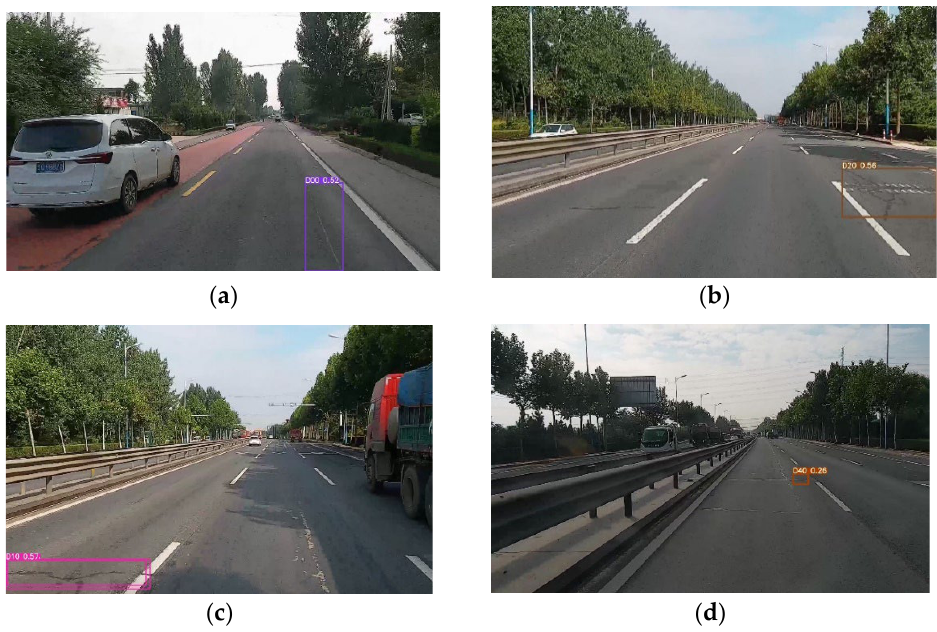
Figure 7. The pavement crack detection results of YOLOV5s-CoordAtt: ( a ) longitudinal crack; ( b ) transverse crack; ( c ) alligator crack; ( d ) pothole.